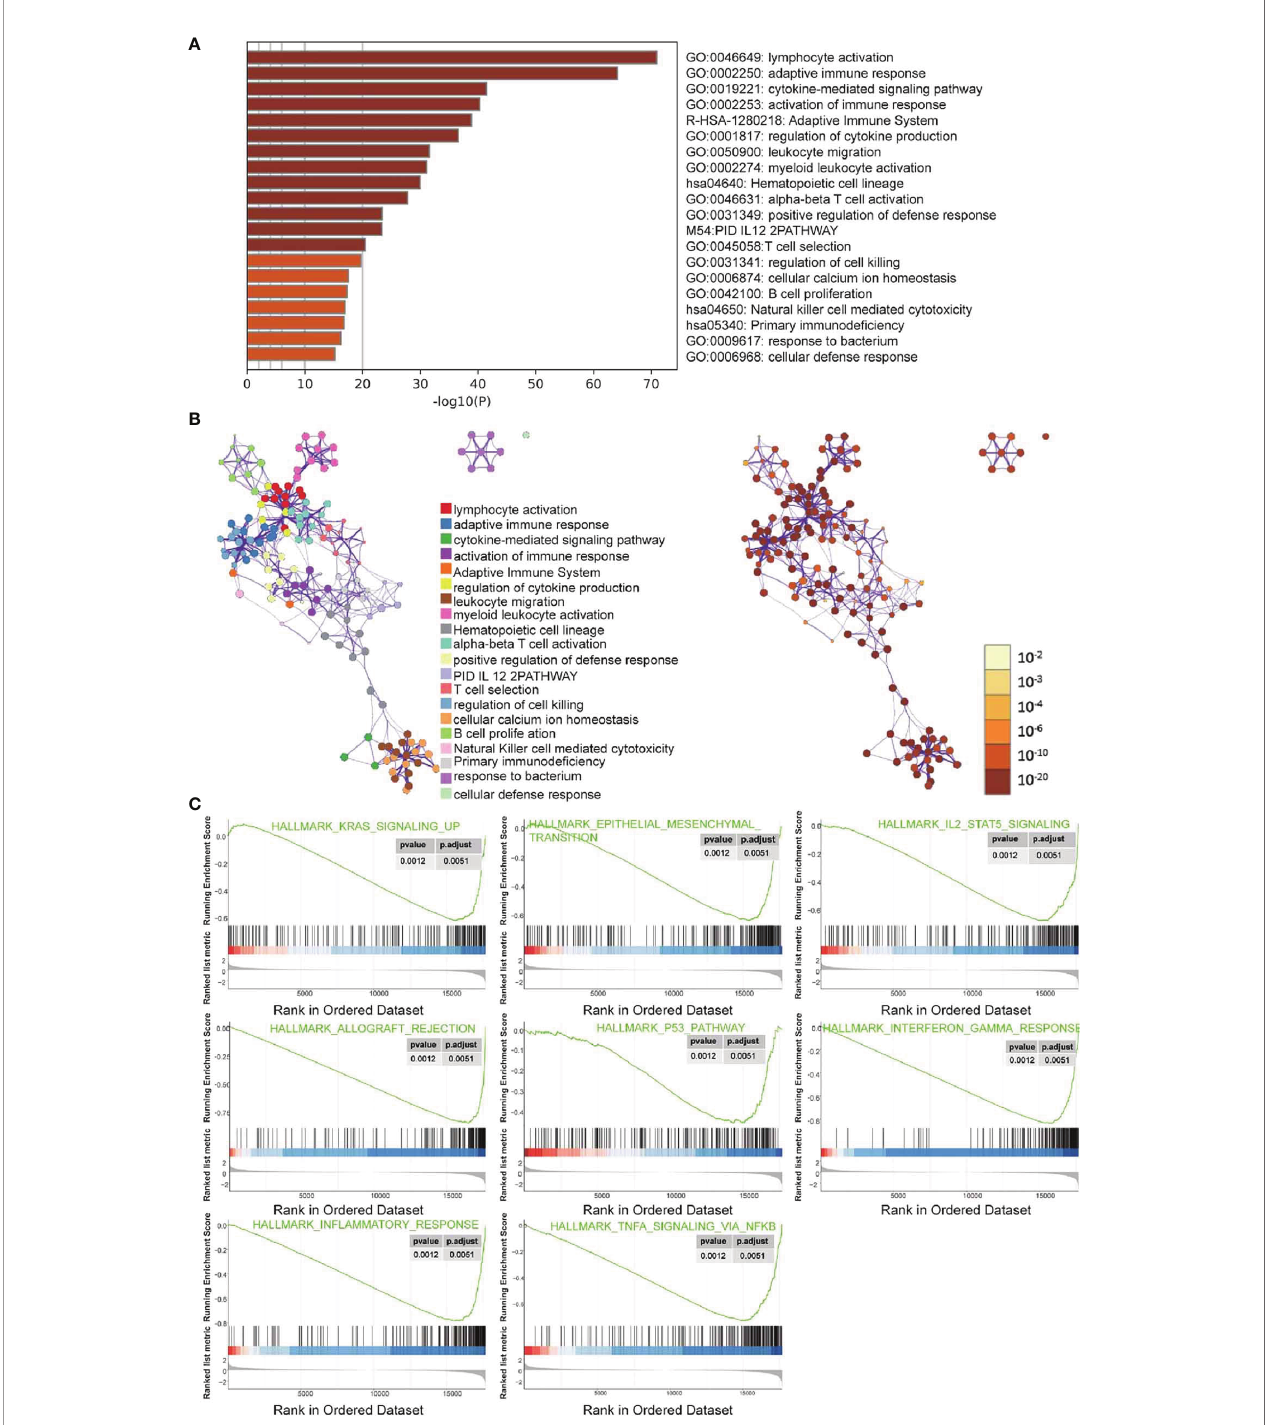
FIGURE 4 | Signal pathway enrichment analysis was performed on the differentially expressed mRNAs in cluster (A) and cluster (B) For enrichment analysis in the Metascape database, each term is represented by a circular node, and its size is proportional to the number of input genes in the term. Nodes of the same color belong to the same cluster. Terms with similarity scores > 0.3 are linked by edges, and nodes in the same condensed network are colored with p-values. (A, B) The functions of 19 ARGs were mainly enriched in lymphocyte activation, adaptive immune response and cytokine-mediated signaling pathway. (C) Partial display of the GSEA analysis